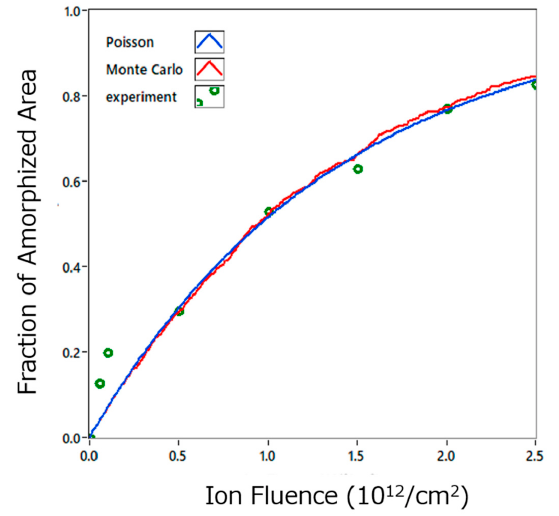
Figure 2. Fraction of non-amorphized area as a function of Xe ion fluence. Green circles, blue line, and red line represent the experimental result [21], result calculated by Equation (6) and the result from two-dimensional images, respectively. The logarithmic scale is used on the vertical axis.